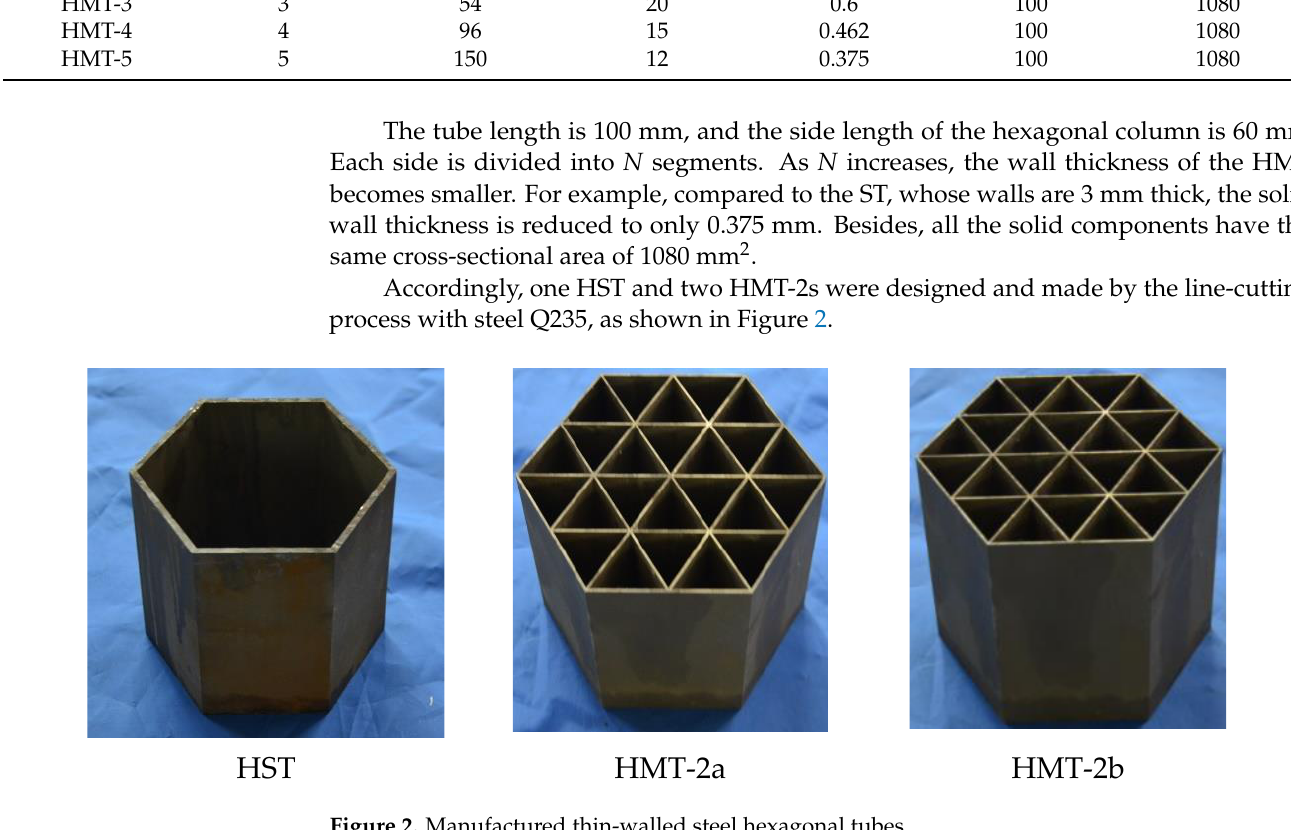
Table 1. Dimensions of designed hexagonal thin-walled tubes.